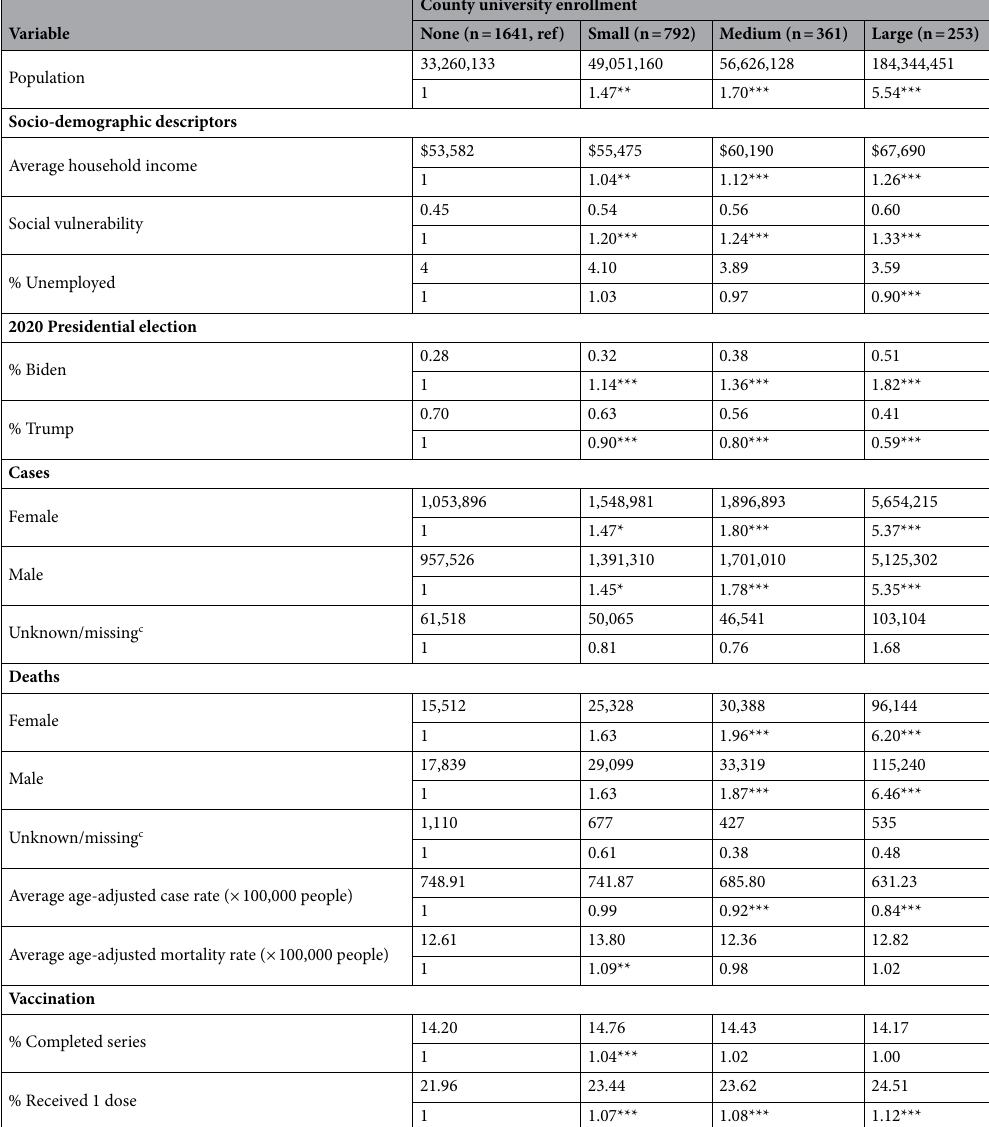
Table 1. Summary of United States population (U.S. Census 2010) and key socioeconomic, demographic, and political variables by race & ethnicity and county total university enrollment (none, small, medium, and large) (Aim 1). Cases and deaths labeled as unknown/missing denote individuals where gender was not provided. *Data describing trends from January 1, 2020–March 30, 2021. a Comparison of means analyzed using Dunnett’s Test (race & ethnicity control = white population; county university enrollment control = none). b The following correspond to the following statistical values: * = p < 0.05, ** = p < 0.01, * p < 0.001. c Unable to statistically